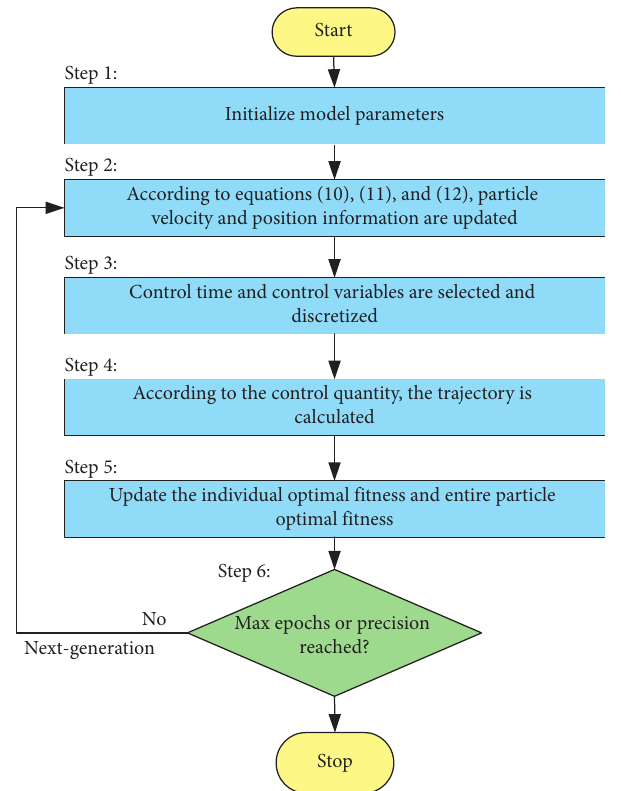
Figure 3: Process of propose PSO algorithm. After the optimi- zation program starts, the particle is initialized first and then it- eratively calculated according to the algorithm until the program is terminated after the stop condition is